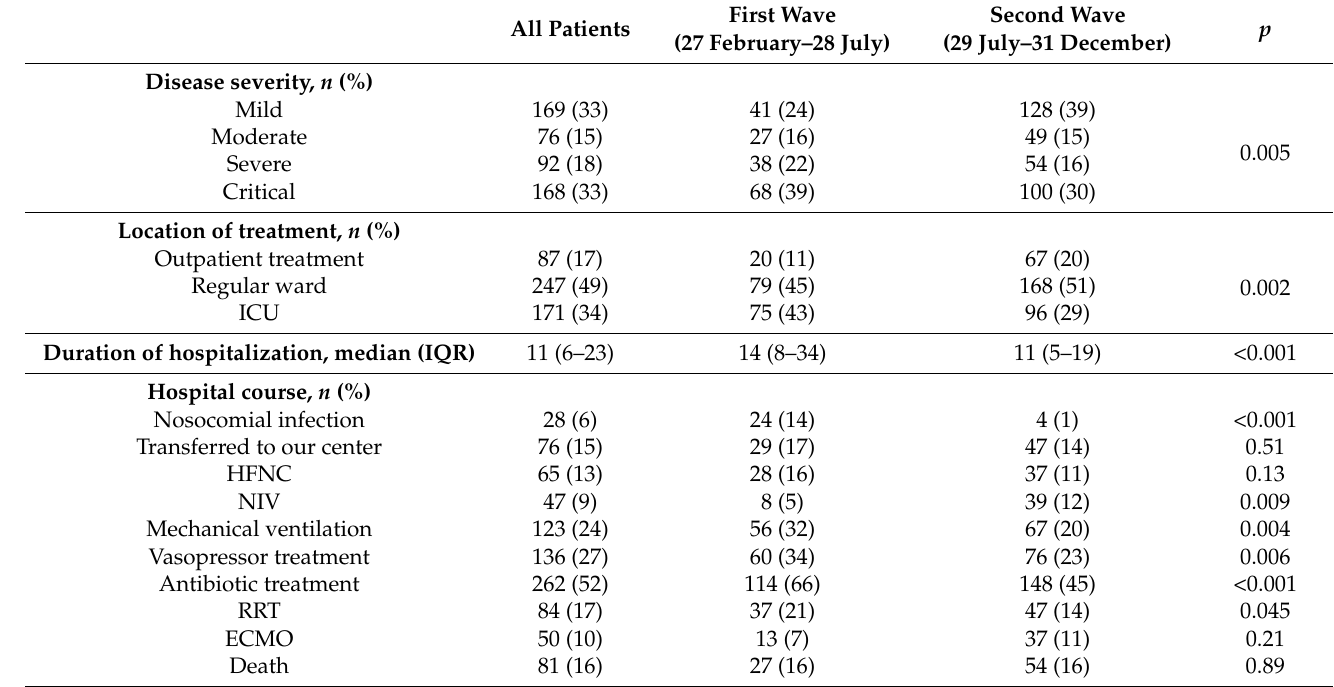
Table 2. Course of disease.